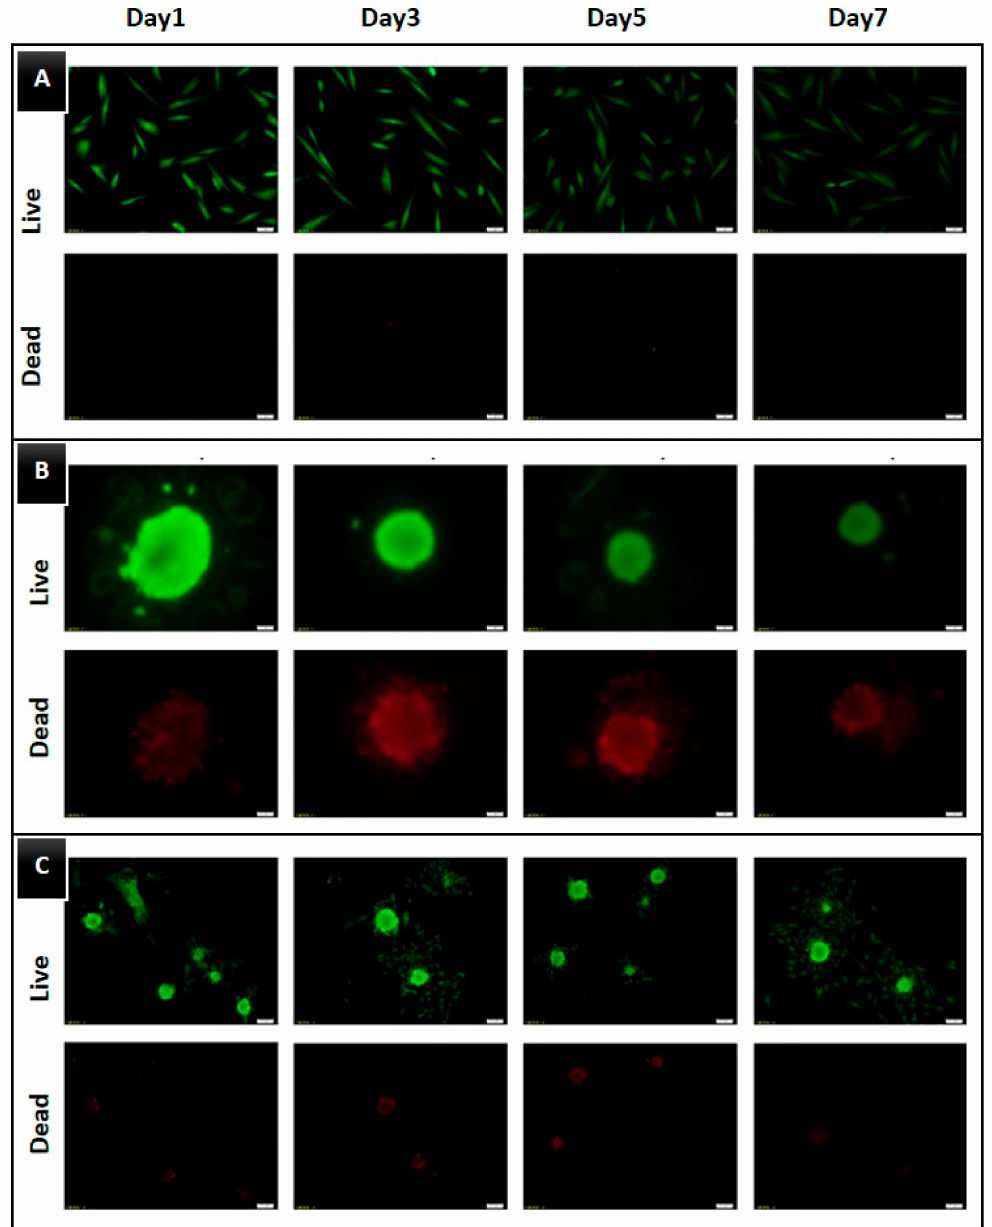
Figure 3. Live / Dead cell assay images of each group on days 1, 3, 5, and 7. ( A ) 2D group, with plain culture plate, ( B ) SF group, with U-bottom plate, ( C ) ULA group, with flat-bottom ultra-low attachment plate. The live and dead cell images are